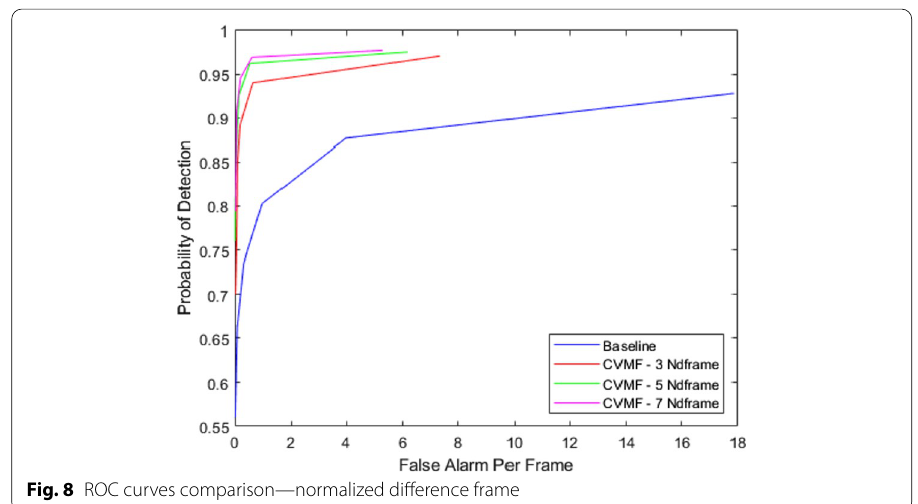
Fig. 8 ROC curves comparison—normalized difference frame